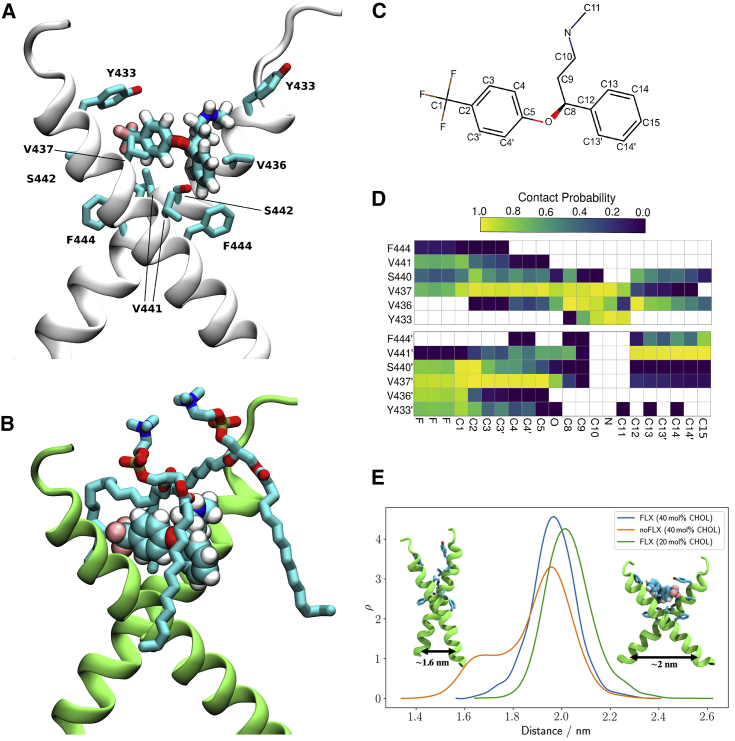
Model of fluoxetine interaction with TRKB transmembrane domainThe fluoxetine binding pocket at the dimeric interface of the TRKB transmembrane helices.(A) A representative snapshot showing fluoxetine in the crevice between the TRKB monomers. Fluoxetine is shown in licorice and the protein in cartoon representations. The side chains that interact with the drug are labeled and shown in licorice.(B) Fluoxetine binding involves lipid molecules, which provide a closed cavity for the drug. The protein is shown in green cartoon, the drug in van der Waals, and the lipids in licorice representations.(C) The chemical structure of fluoxetine. The atom names are labeled and the chemically equivalent atoms are indicated with an apostrophe.(D) The contact probability between drug heavy atoms and the interacting protein residues. The upper and lower panels correspond to the two different transmembrane helices (residues of the second helix are tagged with an apostrophe). Contact probabilities are calculated using a minimum distance cutoff of 5 Å (system 10).(E) The distributions of the distance between the center of mass L451–L453 Cα atoms of each monomer are shown for membranes with 20 mol % cholesterol (green; system 9), 40 mol % cholesterol with (blue; system 10) and without bound FLX (orange; system 7).See also Figures S3 and S6 and Table S1.